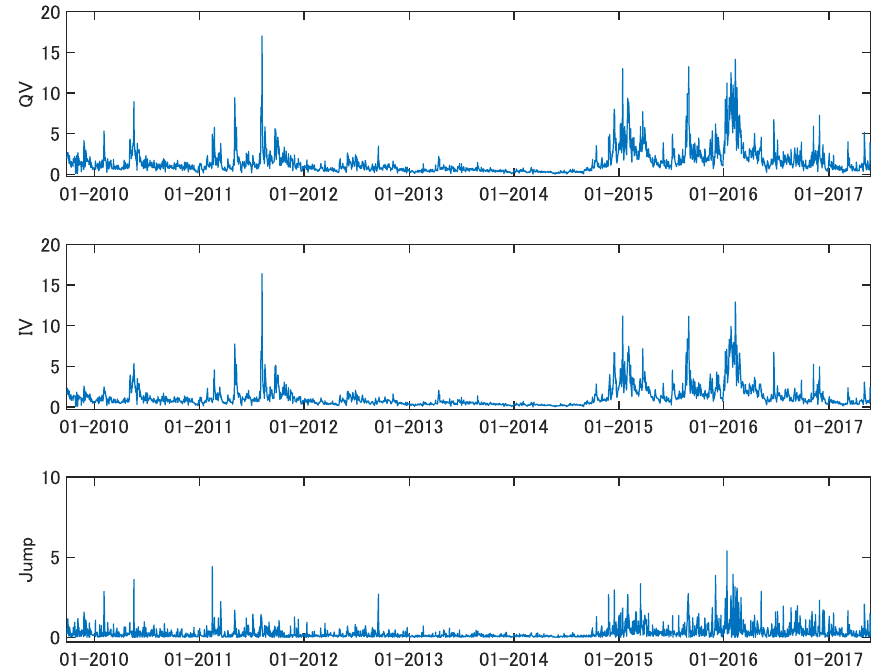
Figure 2. Estimates of Quadratic Variation, Integrated Volatility, and Jump Variability for Gold